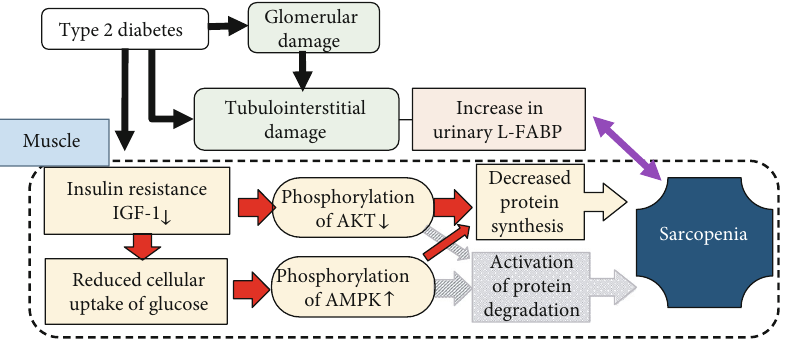
Figure 11: Molecular mechanism underlying the progression of sarcopenia in type 2 diabetes. Disruption to insulin/IGF-1-Akt signaling due to insulin resistance and low serum IGF-1 levels was considered to reduce muscle protein synthesis and to provoke abnormalities in muscle strength and mass in the SDT fatty rats. Furthermore, phosphorylation of AMPK due to reduced cellular uptake of glucose led to suppression of muscle protein synthesis. On the other hand, the involvement of muscle protein degradation signaling in muscle depression in the SDT group may be